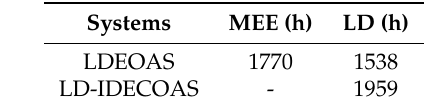
Table 4. Operation time for the membrane enthalpy exchanger (MEE) and the liquid desiccant (LD) system when the MEE is operating.